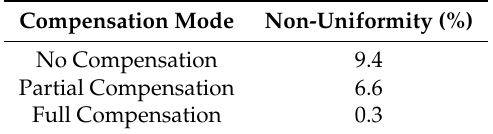
Table 3. Non-uniformity achieved with different compensation modes.